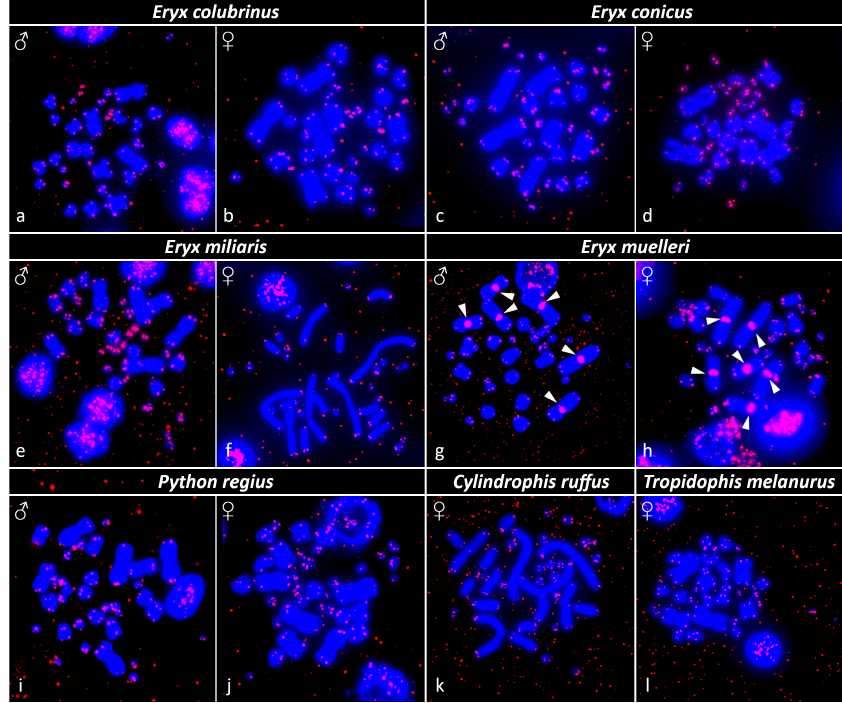
Figure 3. The distribution of telomeric repeats (TTAGGG) n in metaphases. ( a , b ) Eryx colubrinus , ( c , d ) Eryx conicus , ( e , f ) Eryx miliaris , ( g , h ) Eryx muelleri , ( i , j ) Python regius , ( k ) Cylindrophis ruffus, and ( l ) Tropidophis melanurus . Chromosomes with ITRs are marked with arrowheads. Sex is indicated.